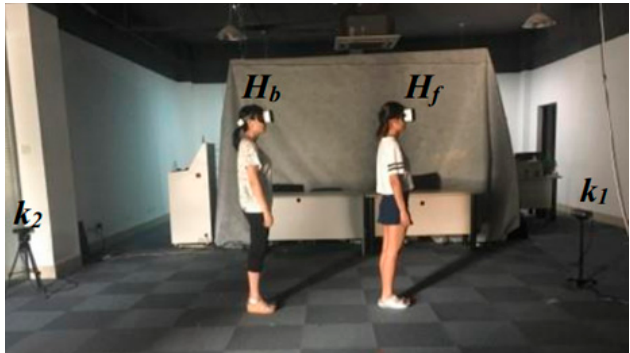
Figure 10. Example test environment.